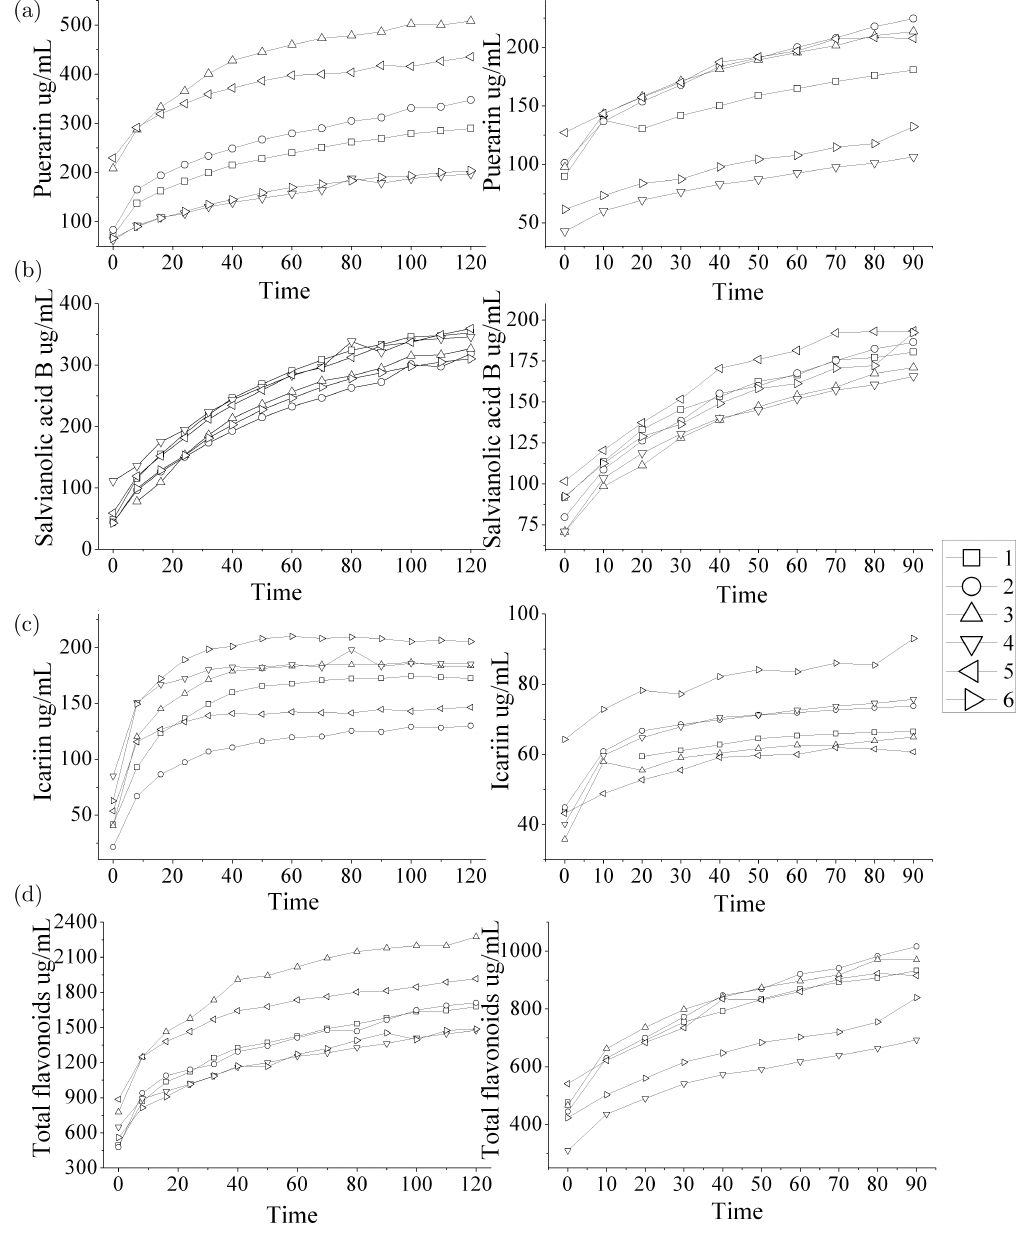
Fig. 2. Time evolution of puerarin (a), salvianolic acid B (b), icariin (c), and total °avonoids (d): 1 meant the ¯rst extraction process and 2 meant the second extraction